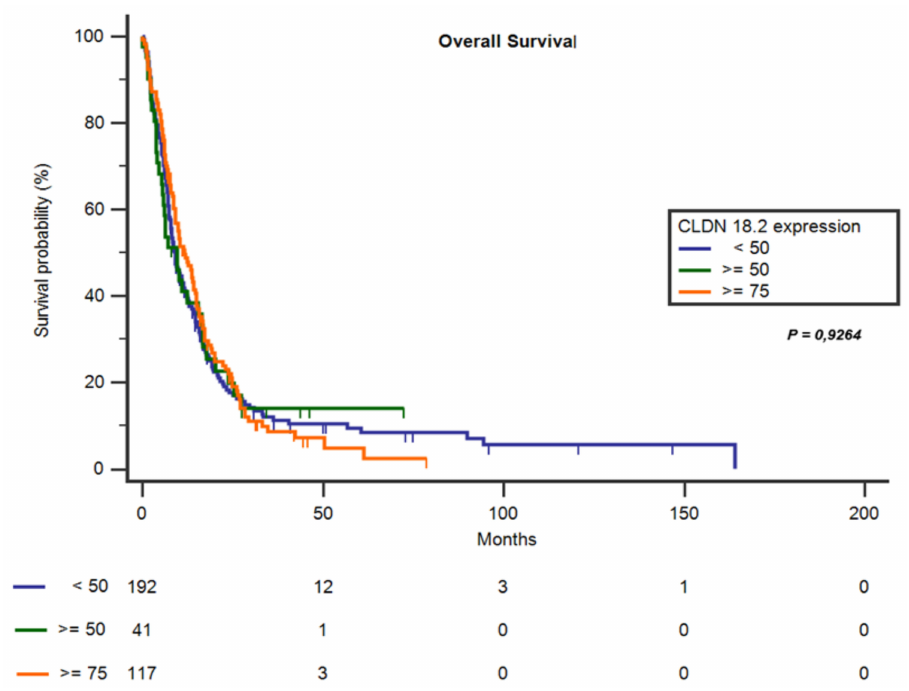
Figure 2. Overall survival time in patients with CLDN18 expression (cut-off of 75% and 50%) compared with patients who were claudin-18 negative